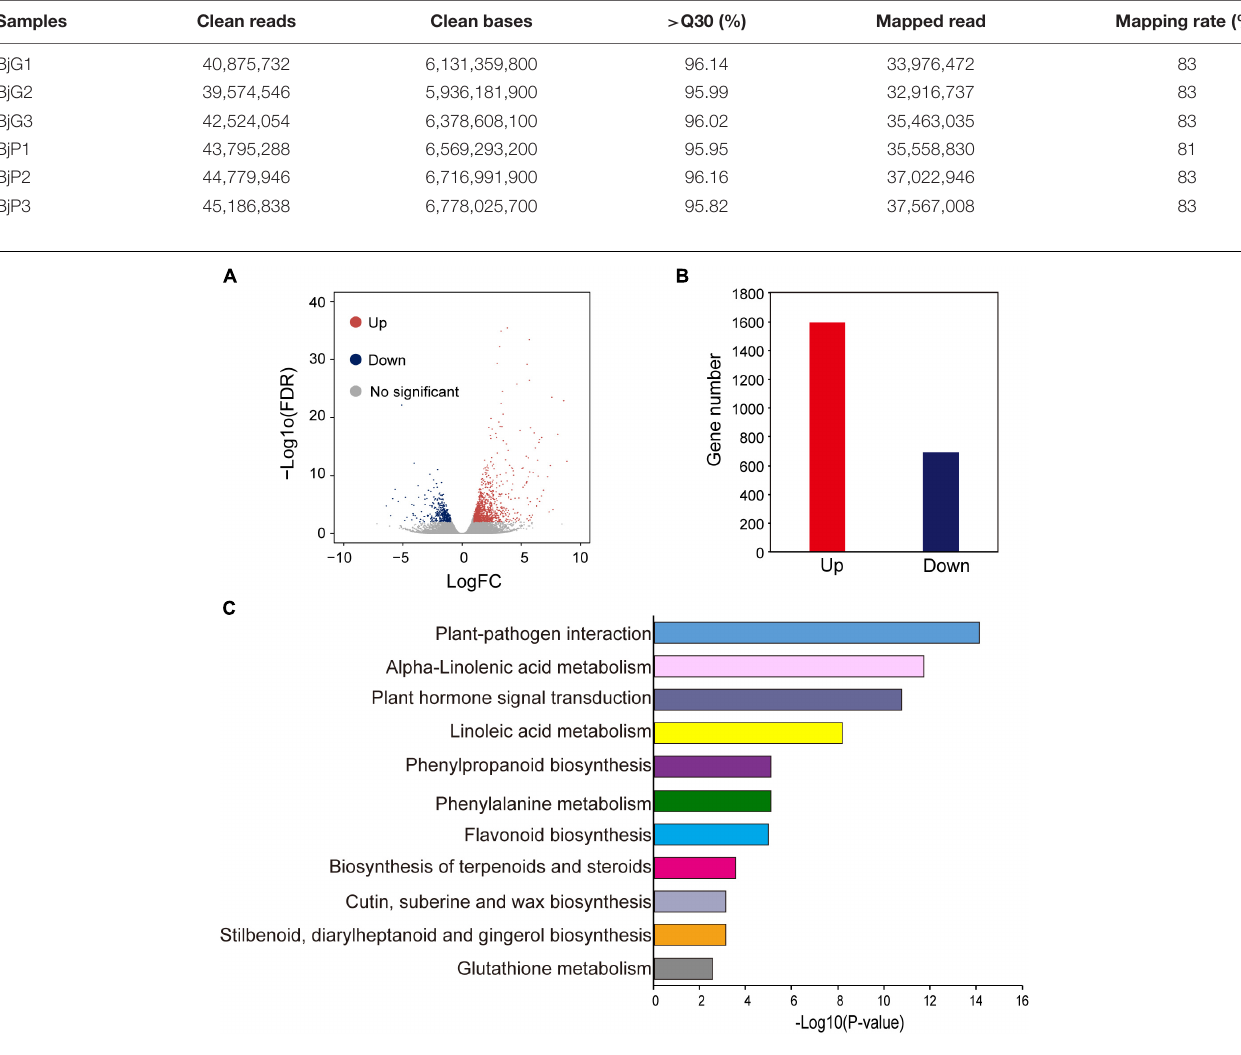
TABLE 1 | Summary of RNA-seq data from purple and green leaves in B. juncea. Samples Clean reads Clean bases Mapped read